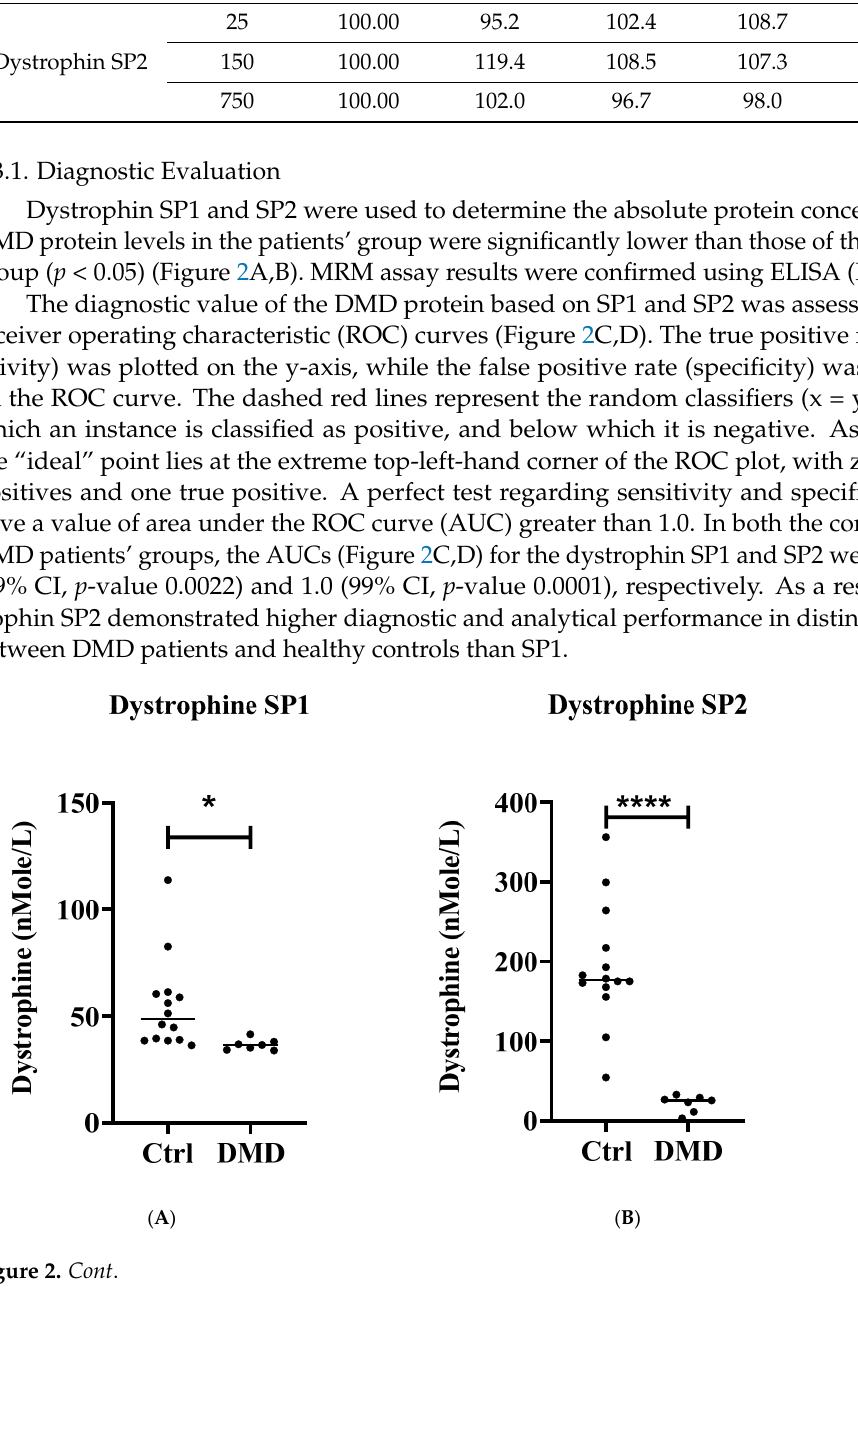
( D ) Figure 2. Dystrophin protein level in dried blood spot (DBS). The dystrophin protein level in DMD patients and healthy controls (Ctrl) was based on ( A ) dystrophin SP1 and ( B ) dystrophin SP2. The sensitivity and selectivity of CF based on these signature peptides were evaluated using ( C ) ROC curve for dystrophin SP1 with AUC 0.9184 (99% CI, p -value 0.0022) and ( D ) dystrophin SP2 with AUC 1.0 (99% CI, p -value 0.0001). The dashed red lines represent the random classifiers (x = y), above which an instance is classified as positive, and below which, it is negative. * p < 0.05, **** p < 0.0001.